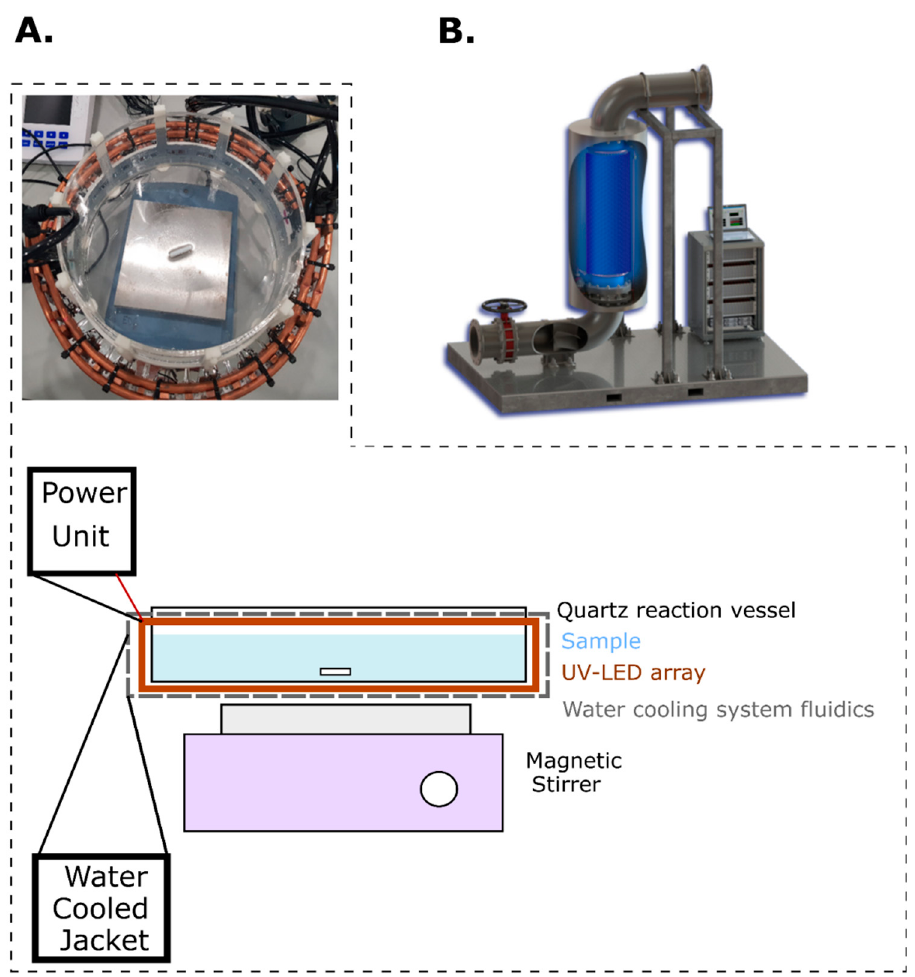
Figure 1. ( A ) Experimental setup of bench-scale ultraviolet light-emitting diode (UV-LED) reactor; ( B